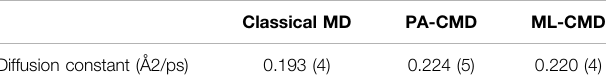
TABLE1| Theself-diffusionconstantsfromclassicalMD,PA-CMD,andML-CMD simulations, respectively. The last digit in the parenthesis marks the